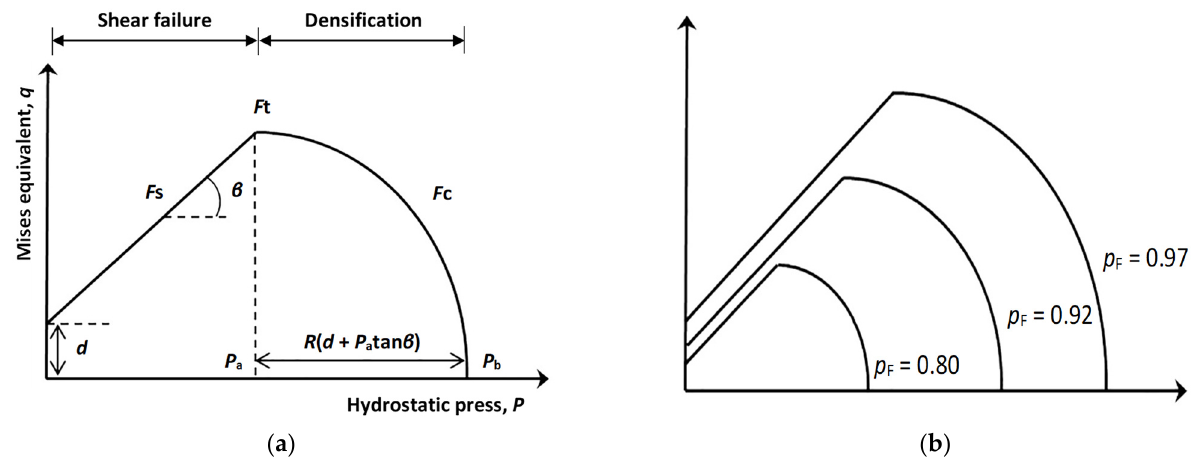
Figure 3. ( a ) The Drucker–Prager Cap (DPC) model and its parameters and ( b ) family of DPC models for different levels of relative density over a range of